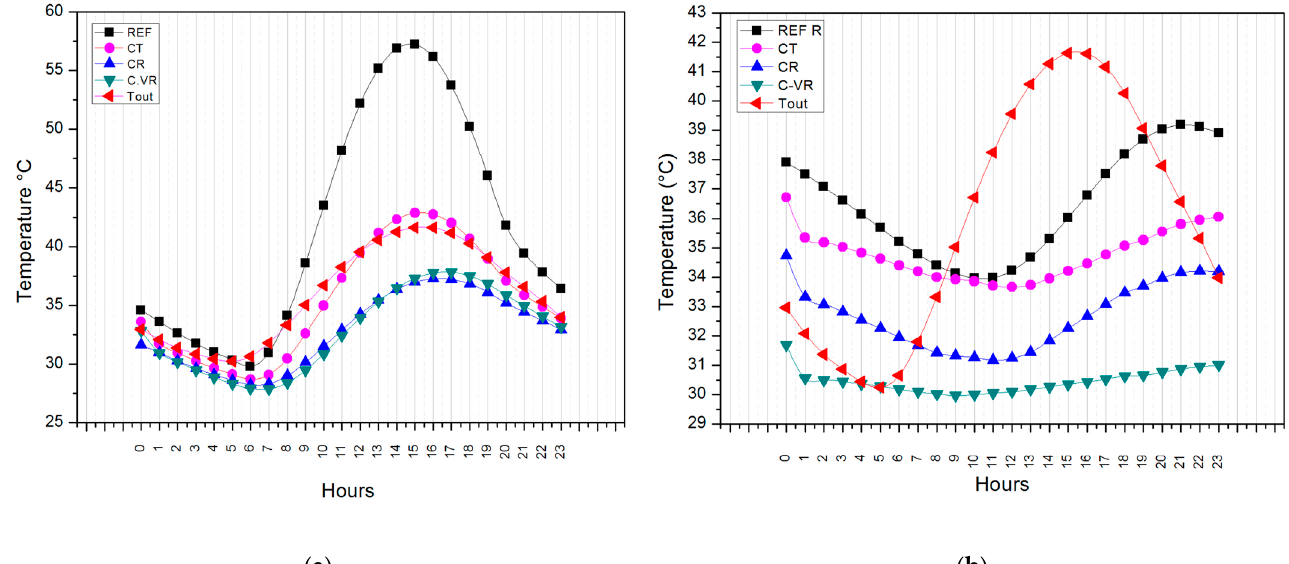
Figure 10. ( a ) Diurnal variations of the roof surface temperature. ( b ) Diurnal variations of the ceiling surface temperature. surface